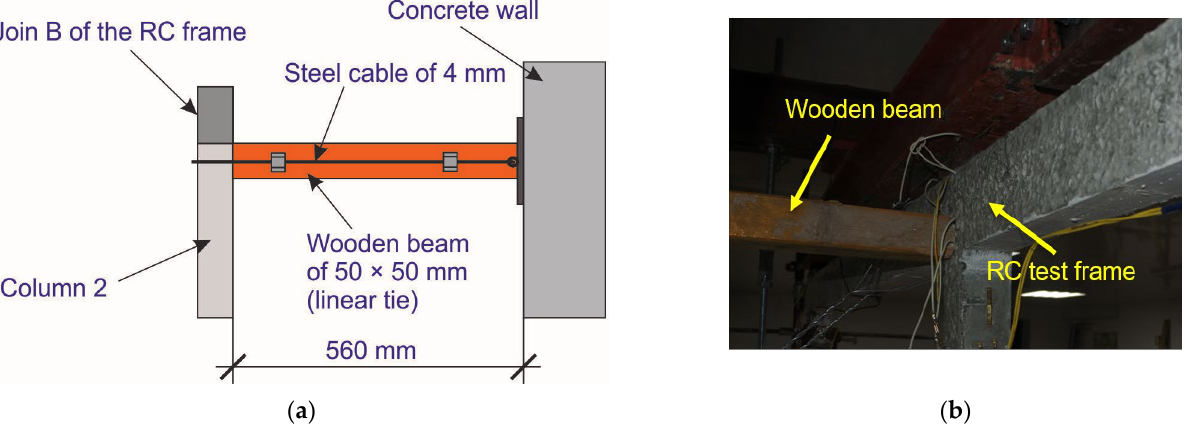
Figure 5. The scheme ( a ) and a general view ( b ) of linear ties fixing joint B in the cross direction of the test frame.